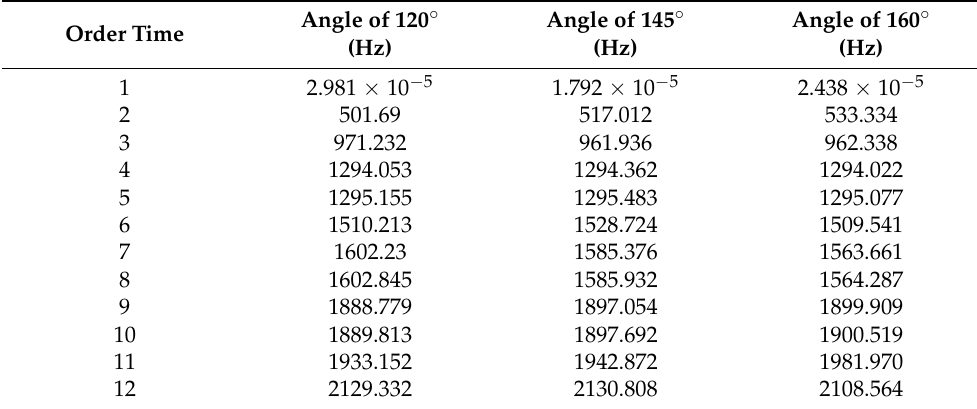
Table 2. Natural frequencies of mufflers with different angles.